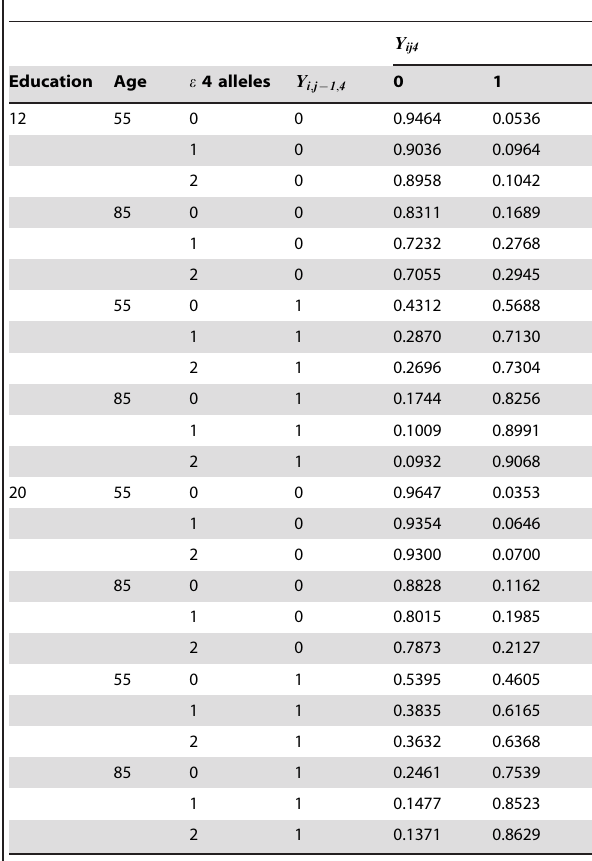
Table 6. The estimated transition probability matrix of binary cognitive status measured by COGSTAT in Alzheimer’s disease patients at the age of 55 or 85, having 12 or 20 years of eduction, and carrying no, one, or two APOE- e 4 alleles.